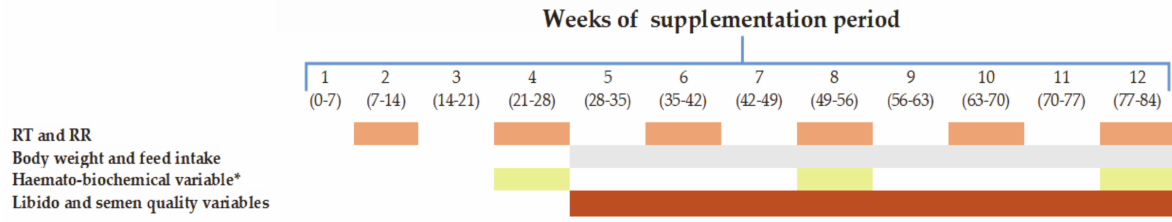
Figure 1. Diagram for the experimental design. RT= rectal temperature; RR= respiration rate; * Haematological variables were carried out at week 12